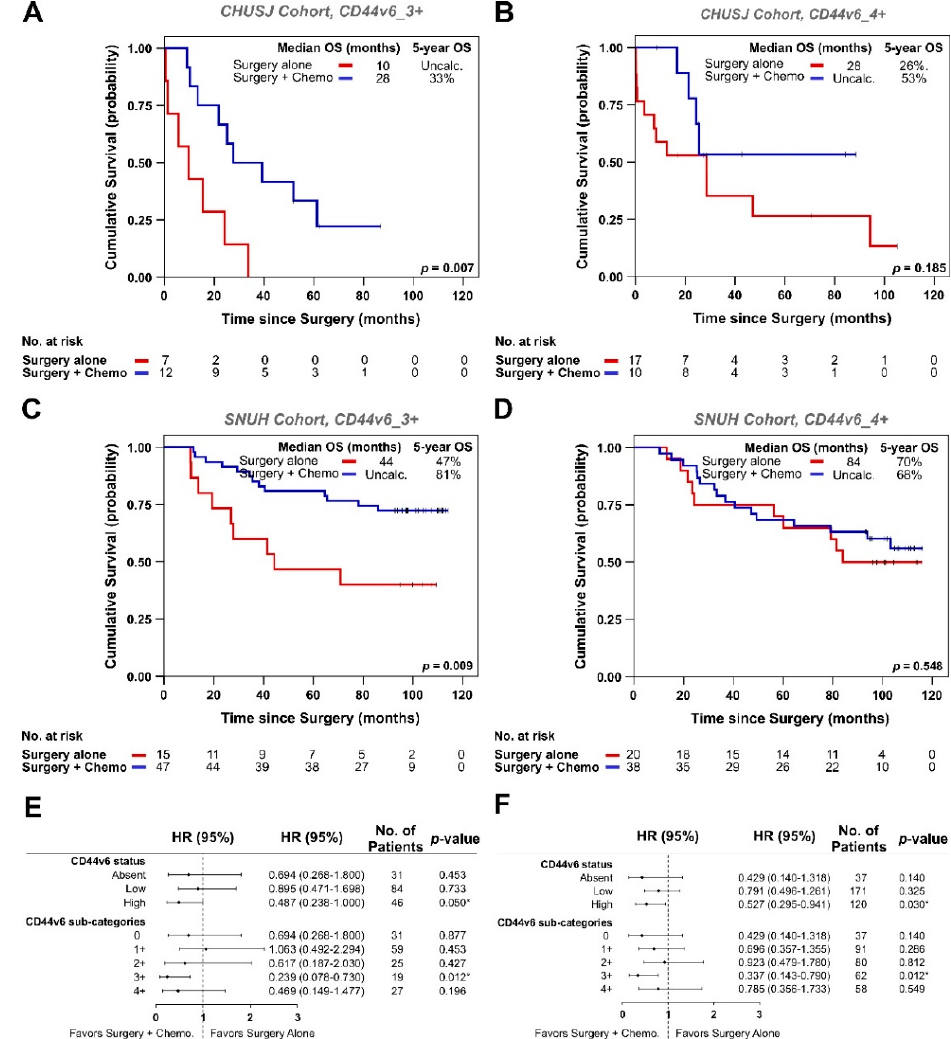
Figure 4. Kaplan–Meier estimates showing OS of GC patients treated with surgery alone (red) or with surgery plus conventional chemotherapy (blue). OS of CHUSJ patients harboring CD44v6_3+ ( A ) or CD44v6_4+ tumors ( B ); OS of SNUH patients harboring CD44v6_3+ ( C ) or CD44v6_4+ tumors ( D ). Only pTNM stage II and III patients are included. The tables below each graph indicate the number of patients still at risk in each group. Median OS and 5-year OS are shown for each patient subgroup; Forest plots showing the benefit of treating CHUSJ ( E ) or SNUH ( F ) GC patients with surgery plus chemotherapy according to CD44v6 classification. * highlights statistically significant